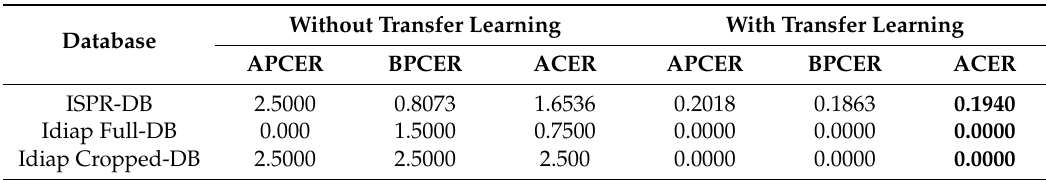
Table 11. PAD errors of CNN-based method with and without applying the transfer learning technique using VGG-16 network architecture in Table 4 (unit: %).